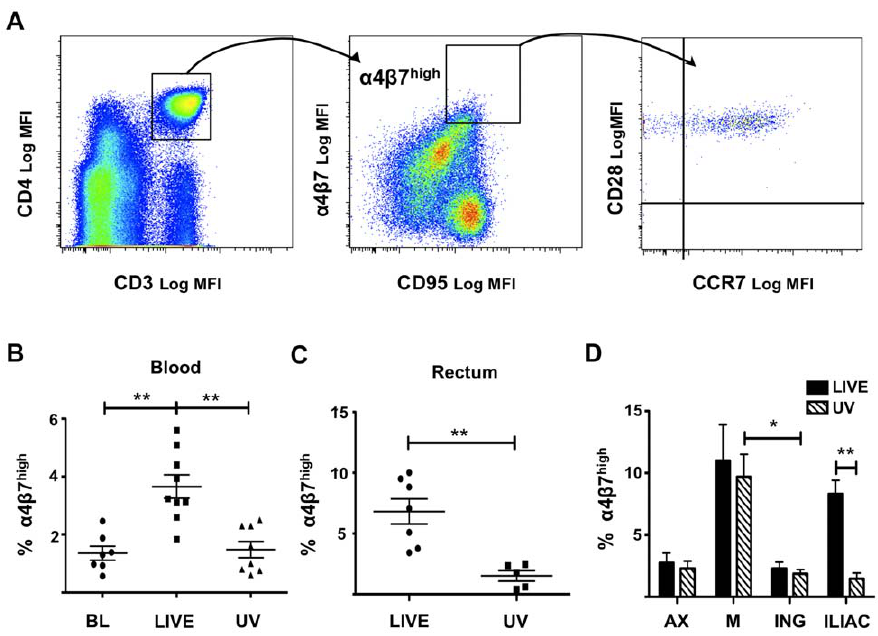
Figure 1. Rectal HSV-2 challenge increases the percentage of a 4 b 7high CD3 + CD4 + T cells in in-vivo . A) The gating strategy for a 4 b 7high CD3 + CD4 + CD95 + T cells in blood is shown from one representative animal. The majority of the a 4 b 7high T cells are CD95 + CD28 + CCR7 + (last plot on the right). B) The percentages (mean 6 SEM) of CD3 + CD4 + CD95 + T cells that are a 4 b 7high in blood are shown at 4 days before infection (BL) and at 6 days p.i. for HSV-2-infected (LIVE, n=9) and UV-HSV-2-treated (UV, n=8) animals. C) The percentages (mean 6 SEM) of CD3 + CD4 + T cells that are a 4 b 7high in rectal mucosa are shown for HSV-2-infected (LIVE, n=7) and UV-HSV-2-treated (UV, n=5) animals 6 days p.i.. D) The percentages (mean 6 SEM) of CD3 + CD4 + CD95 + T cells that are a 4 b 7high in axillary (AX), mesenteric (M), inguinal (ING), and iliac LNs are shown for HSV-2-infected (LIVE, n=5) and UV-HSV-2-treated (UV, n=7) animals. B–C) Each symbol represents an animal. (*p , 0.05, ** , 0.01, ***p # 0.001).